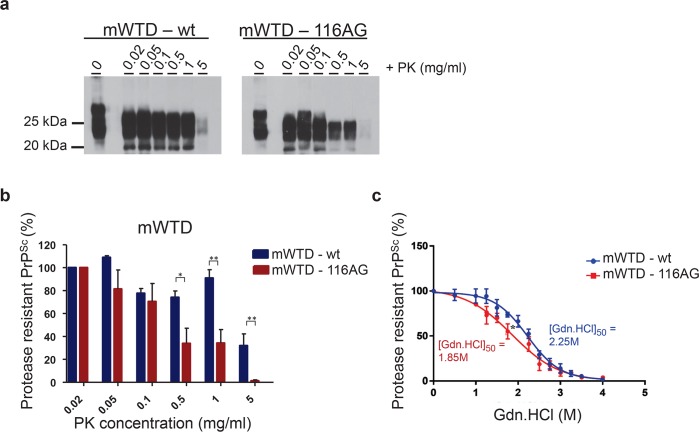
Biochemical properties of mWTD prions.Resistance to PK was assessed using different PK concentrations to digest mWTD-wt (left panel) and -116AG (right panel) brain homogenate. (a) The PrPres Western blot pattern was revealed using monoclonal antibody 4H11 and (b) assessed by densitometric analysis of PrPres signals. *P <0.05 and ** P <0.01 refers to differences between PK resistance of mWTD-wt (blue bars) and -116AG (red bars) and evaluated using unpaired student’s t-test (GraphPad Prism software). (c) Conformational stability of mWTD-wt (blue line) and -116AG (red line) was assessed by densitometric analysis of PrPres signal after guanidine denaturation. *P <0.05 refers to differences between [GdnHCl1/2] from best-fitted sigmoid curves evaluated using unpaired student’s t-test (GraphPad Prism software).